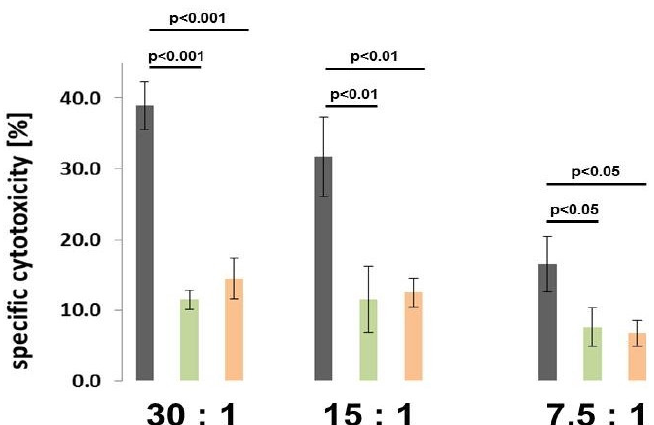
Figure 2. Immune-modulatory activity was tested with peripheral blood mononuclear cells (PBMCs) following stimulation by different MSC544 subpopulations. PBMCs as effector cells alone (gray columns) and after co-culture together with proliferating MSC544 P27 in steady state (green columns) or with growth-arrested confluent MSC544 after permanent culture for 189d (orange columns) were incubated with 51 Cr–labeled K652 target cells at three different effector to target (E:T) ratios and released radioactivity was determined from cell-free supernatants. Minimal (supernatant from samples without effector cells) and maximal radioactivity values (supernatant from detergent-lysed target cells) were used for calculating the percentage of specific cytotoxicity of the effector cells. Data represent the mean ± s.d. ( n = 3) and significance ( p ) was evaluated by paired Student’s- t -test.